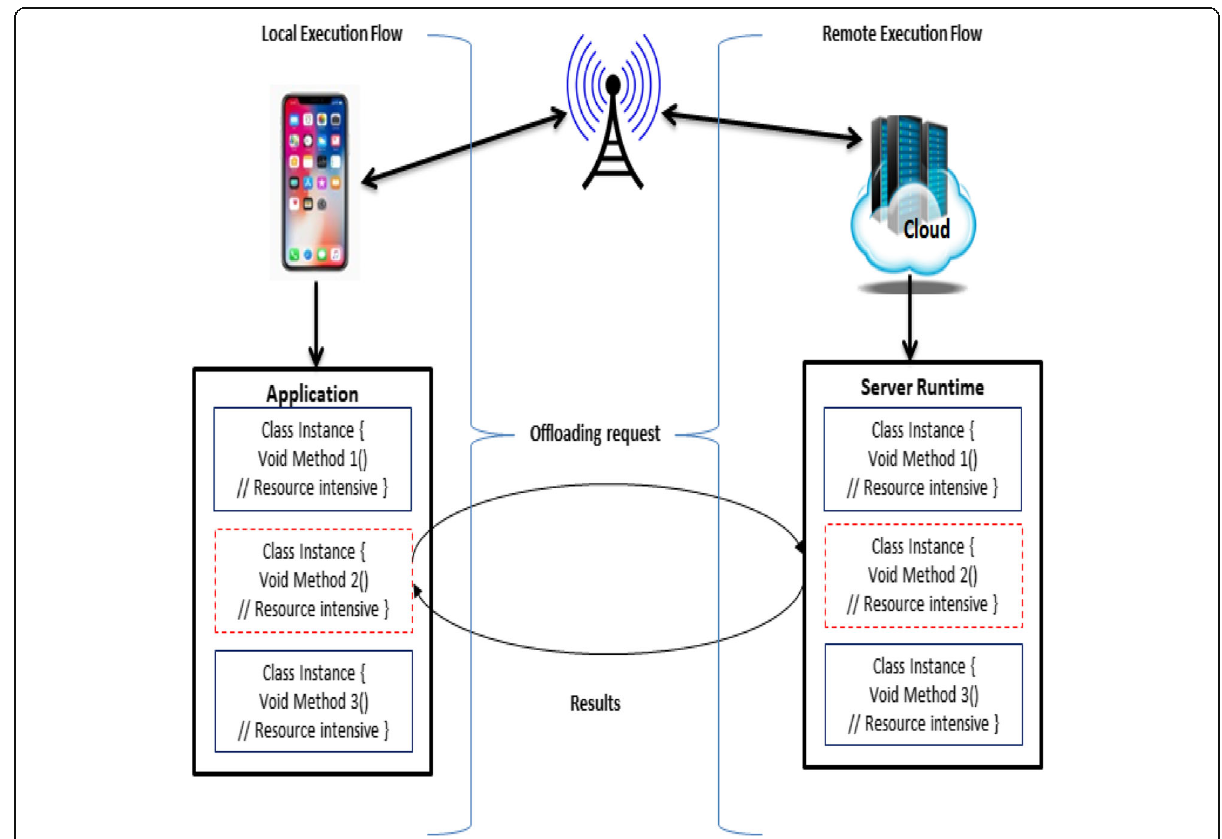
Fig. 1 Application executable code offloading environment. This schematic illustration shows code offloading in respect of local and remote execution environment where device agent requests application execution to its counterpart in the cloud. The cloud agent obtains the execution information and offloads the required code that needs to be executed in the